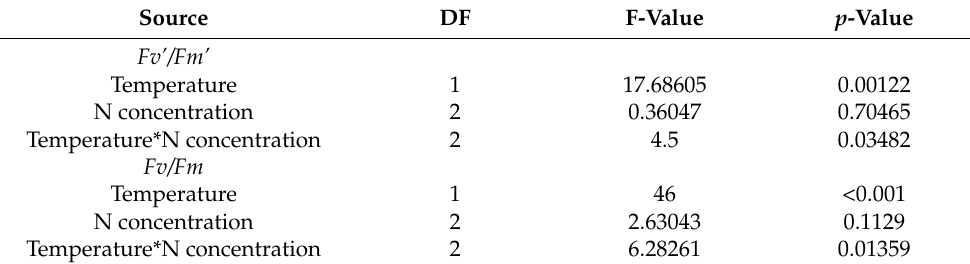
Figure 2. The effective quantum yield ( Fv’/Fm’ ) ( A ) and maximum quantum yield ( Fv/Fm ) ( B ) of S. horneri under LN, IN, and HN treated by CT and ET. Data are means ± SD (n = 3). Horizontal lines represent the significant difference ( p < 0.05) among the temperature levels at the same N concentration, the different capital letters represent significant differences ( p < 0.05) among N concentrations at the elevated temperature, while the different lower-case letters represent significant differences ( p < 0.05) among N concentrations at the ambient temperature. Table 2. Results of two-way ANOVA for S. horneri under low nitrogen (LN), intermediate N (IN), and high N (HN) treated by ambient temperature (CT) and elevated temperature (ET).